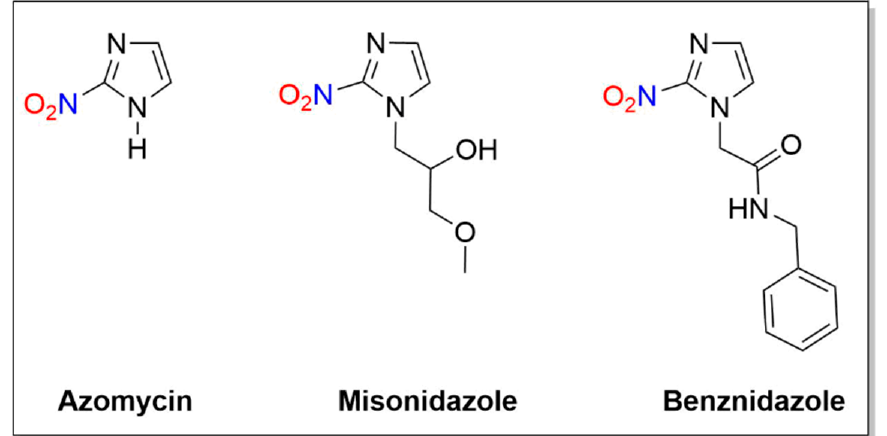
Figure 5. Structures of azomycin, misonidazole and benznidazole.